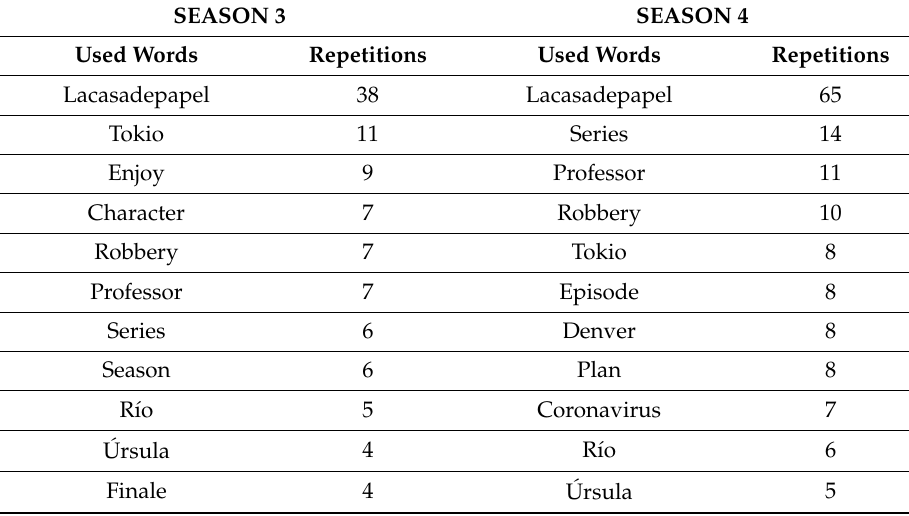
Table 5. Most used words in the tweets about season 3 and